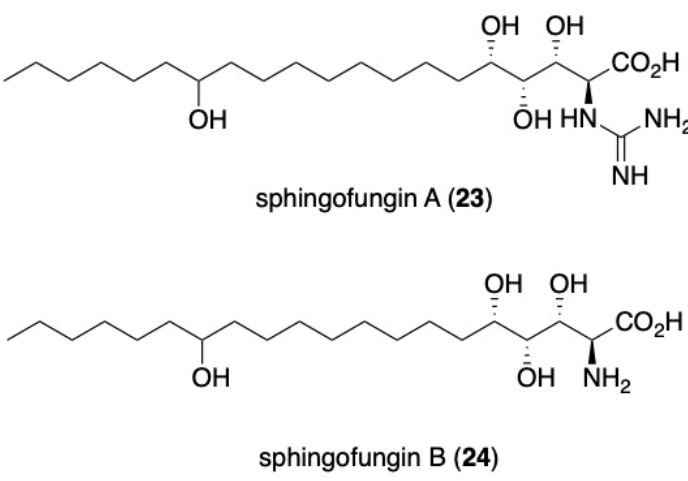
Otaka and Mori’s strategy a formal synthesis of these as well.